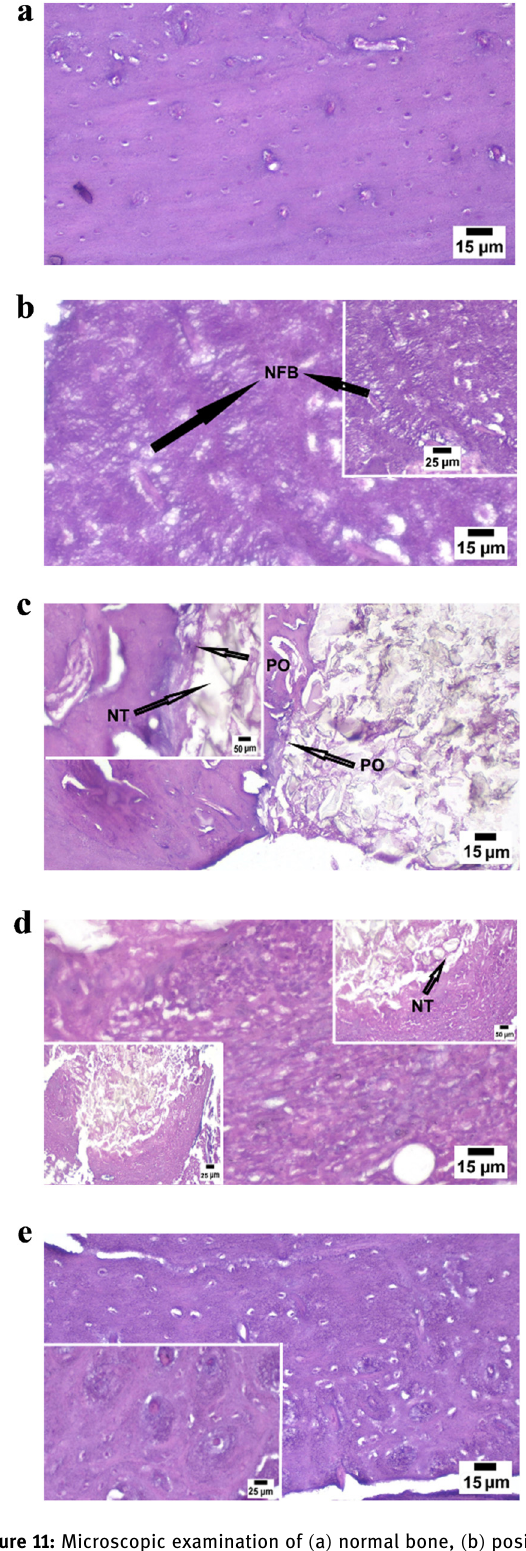
Figure 11: Microscopic examination of ( a ) normal bone, ( b ) positive control and sample containing sintered ( c ) G0, ( d ) G0.25M and ( e ) G0.50M samples. Both G0.25M and G0.50M samples show nearly normal bone after 45 days of implantation. NFB: new formed bone, NT: necrosed tissue and PO: proliferating